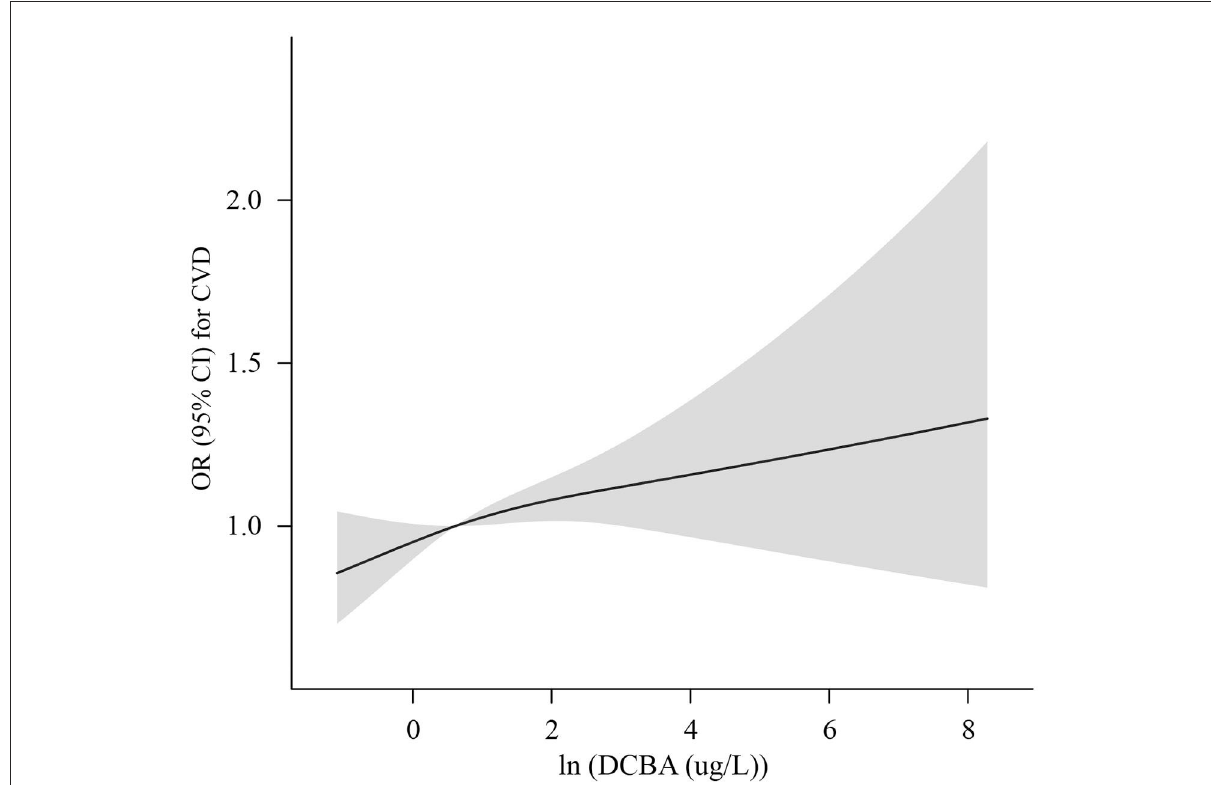
FIGURE1 Adjusted OR (solid lines) with 95% CI (shaded areas) for CVD in urinary concentrations of (In-transformed) DCBA, Adjustments included age, sex, ethnicity, income, education, exercise, smoking, drinking, BMI, hypertension, dyslipidemia, diabetes, and In-transformed